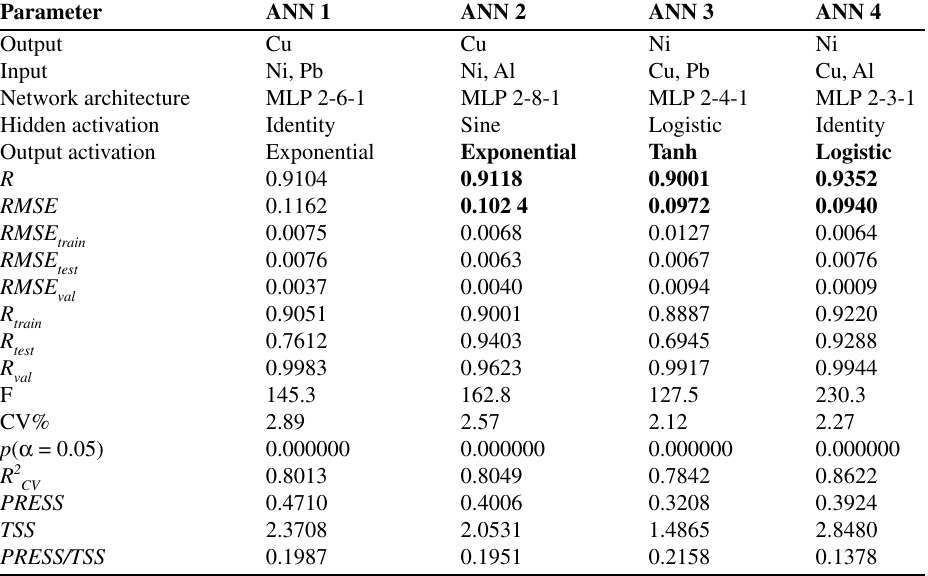
Table 4. Statistical and cross-validation parameters of the established neural networks for prediction of the me- tal contents in different types of chocolate